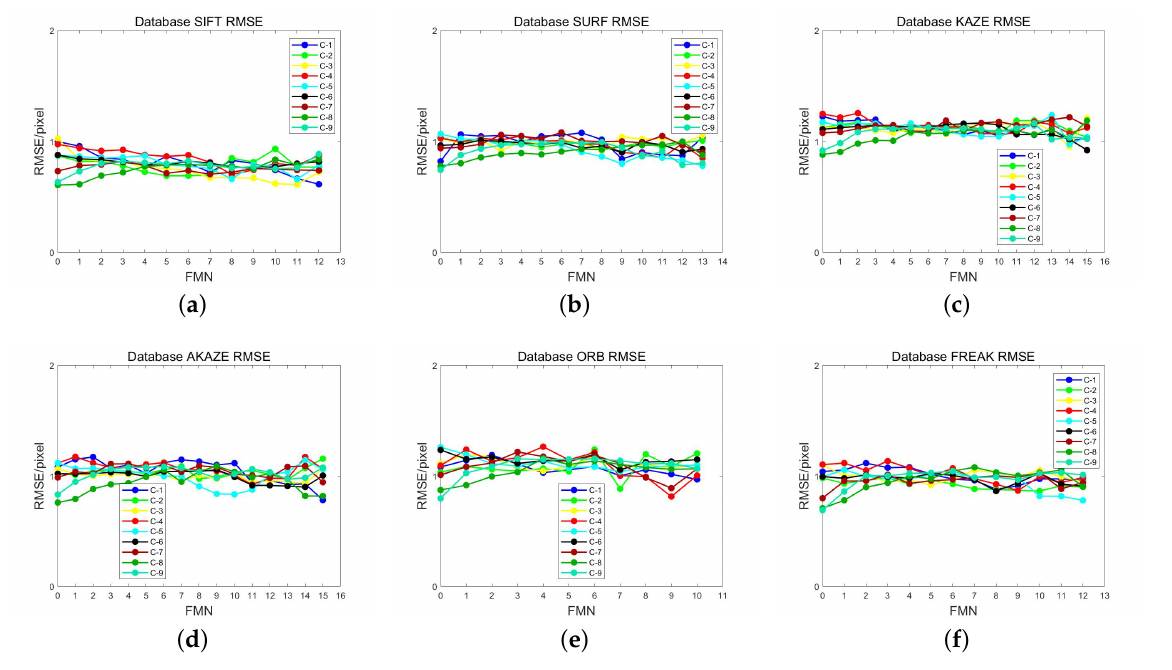
Figure 5. RMSE of different FMN based on different feature databases. ( a ) SIFT. ( b ) SURF. ( c ) KAZE. ( d ) AKAZE. ( e ) ORB. ( f ) FREAK. Table 4. RMSE (pixel) fluctuations for different feature database